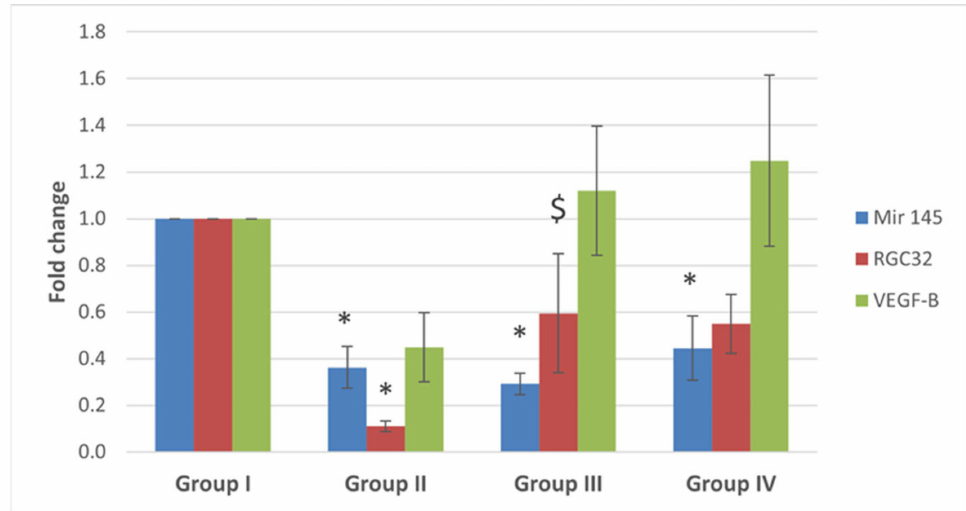
Figure 13. Fold change for miRNA-145, RGC32 and VEGF-B genes expression from real time- poymerase chain reaction results. Data are expressed as means ± SEM ( n = 6) and analyzed using one-way ANOVA followed by post-hoc Bonferroni multiple comparison test. (Symbols: *: p ≤ 0.05 compared to the control group (Group I), and $ indicates p ≤ 0.05 compared to POI group (Group